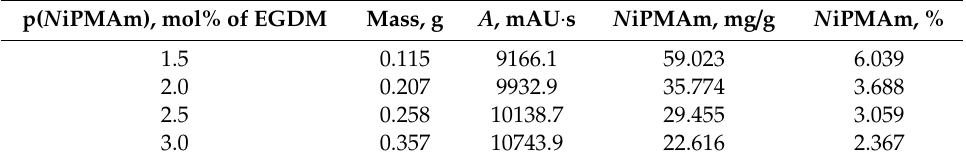
Figure 4. ( a ) HPLC chromatogram of standard solution N iPMAm, c = 0.257 mg / cm 3 ; ( b ) UV spectrum of N iPMAm. Table 1. The peak area values of the p( N iPMAm) xerogel samples masses and the residual amount of N iPMAm calculated in relation to the total mass of homopolymer p( N iPMAm) xerogels and in percent in relation to the initial amount in the reaction